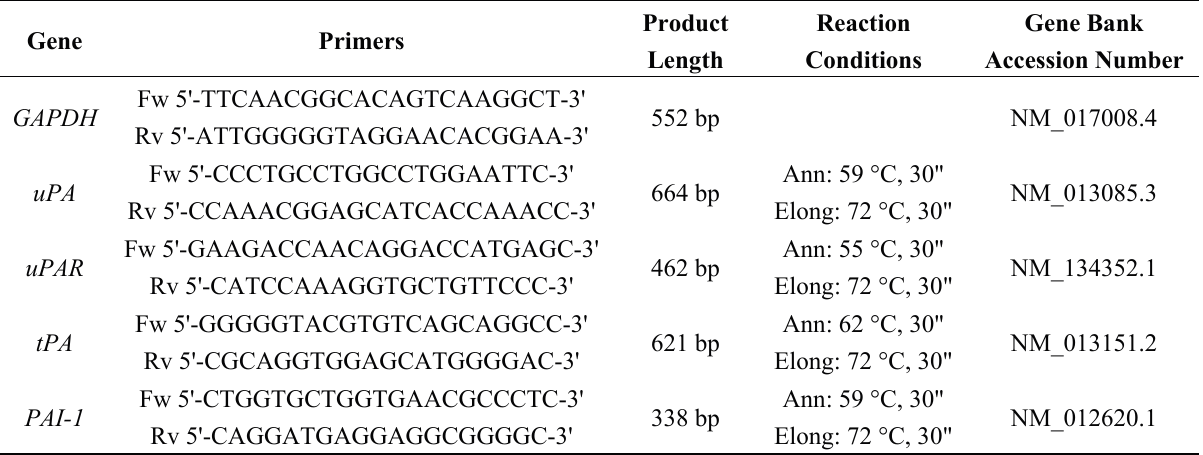
Table 1. Sequence of oligonucleotides used as RT-PCR